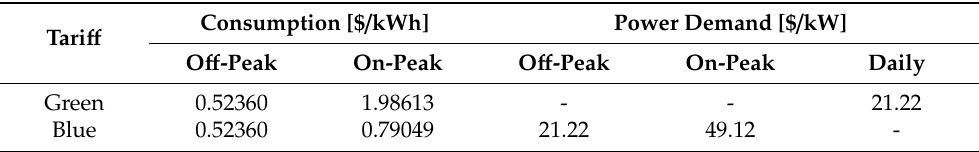
Table 1. Current tari ff values [17].